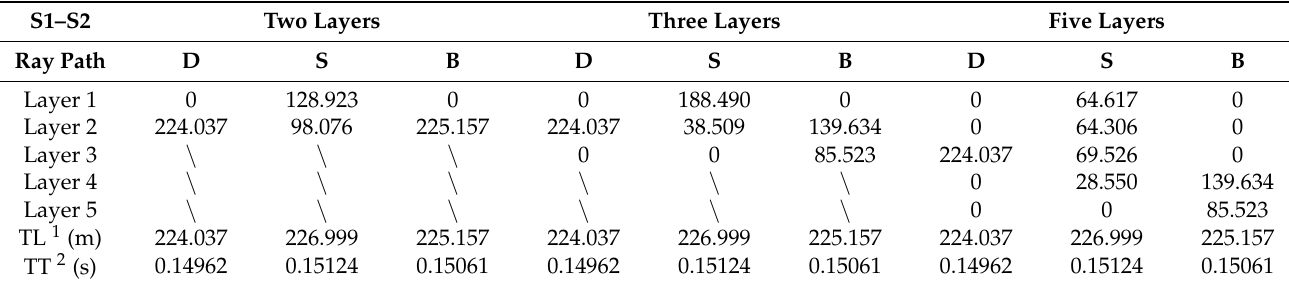
Table 5. Ray length and reference travel time (three rays and five layers).